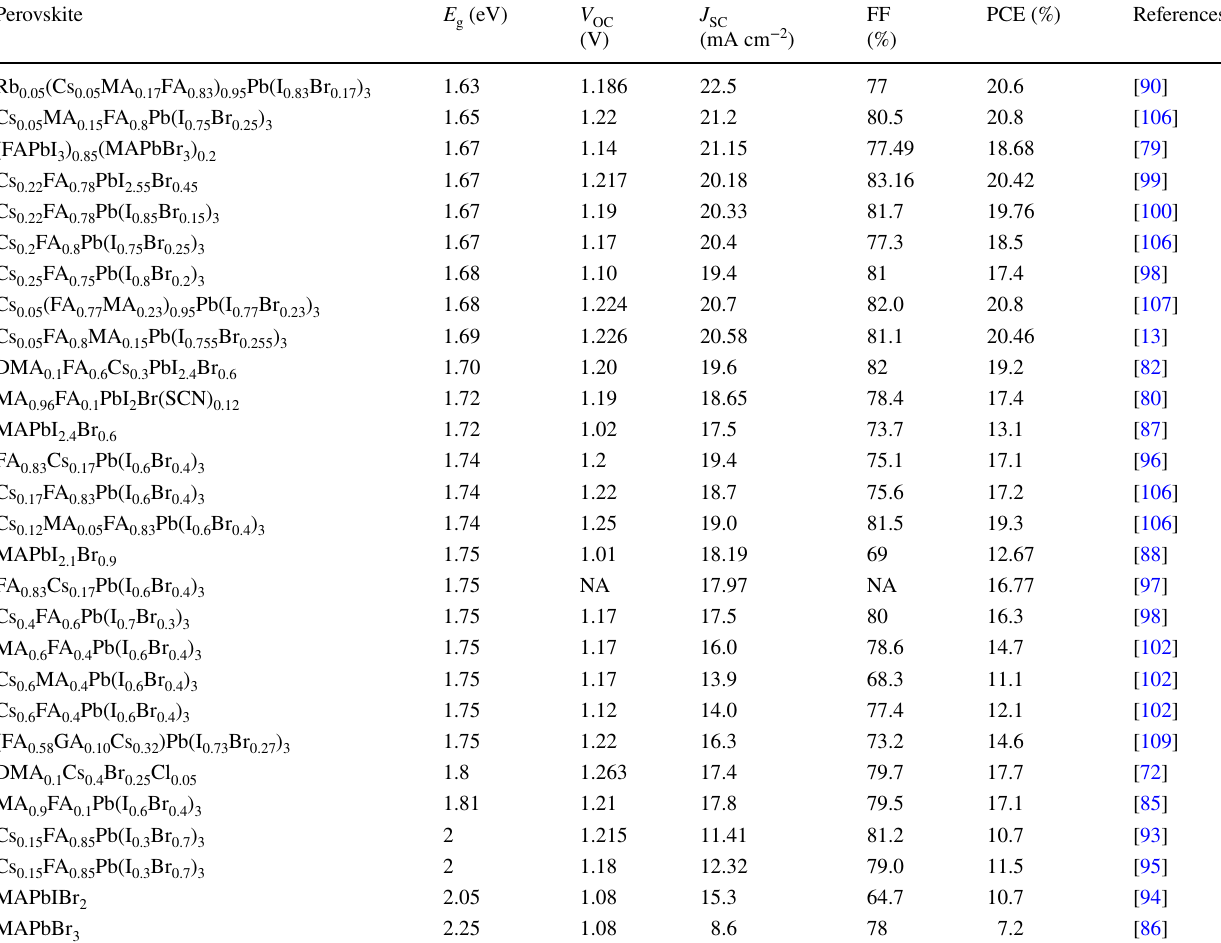
Table 2 Summary of WBG organic–inorganic hybrid PSCs employing composition engineering